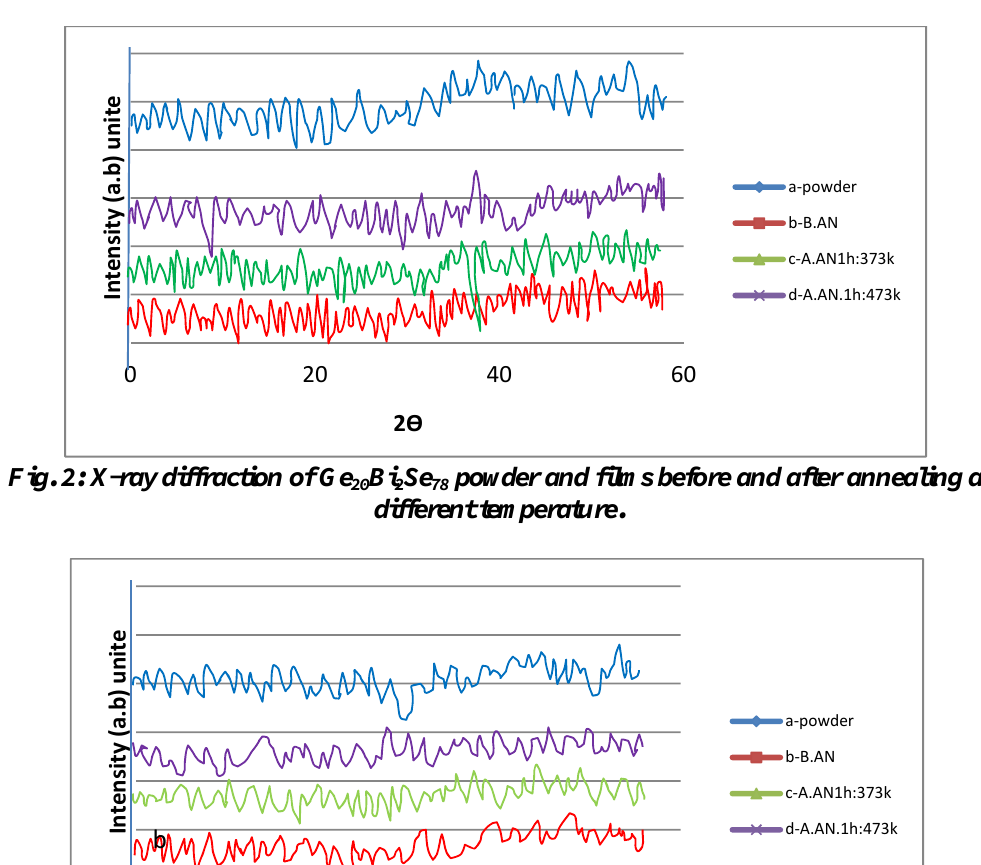
Bi Se powder and films before and after annealing at 20 6 74 different